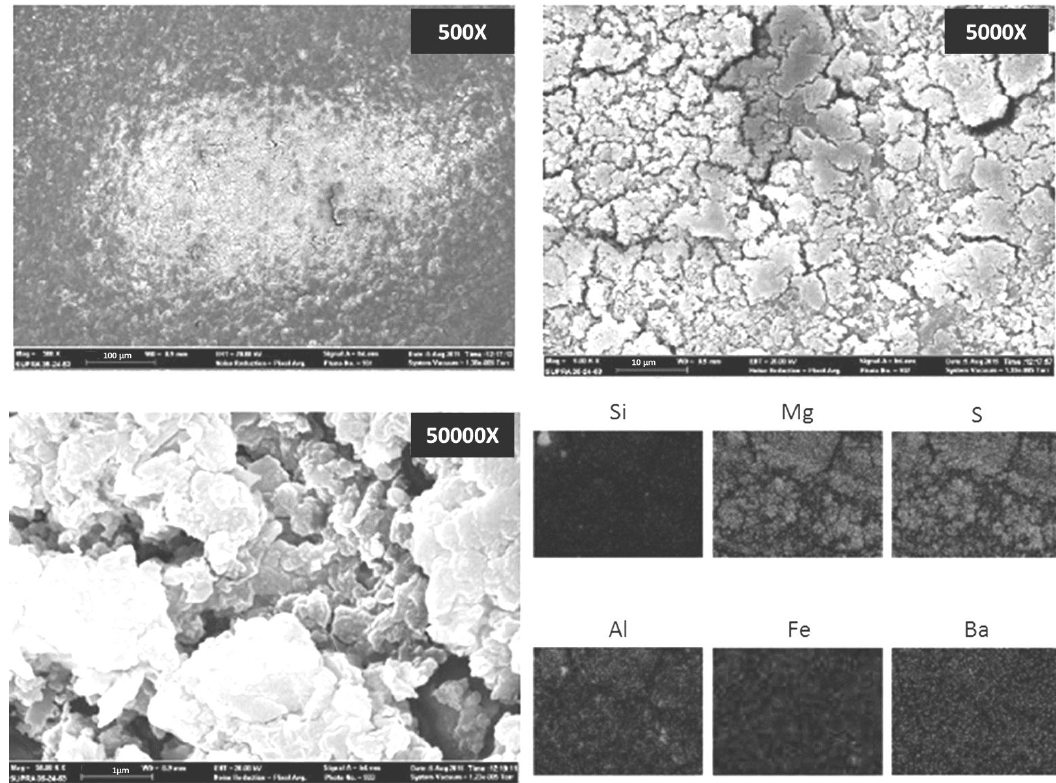
Figure 8. SEM analysis of the particle aggregates collected during ammunition blasting in the “C” sampling site, 20 m from the detonation box. Their chemical composition mapping EDS is showed in the bottom-right pictures.